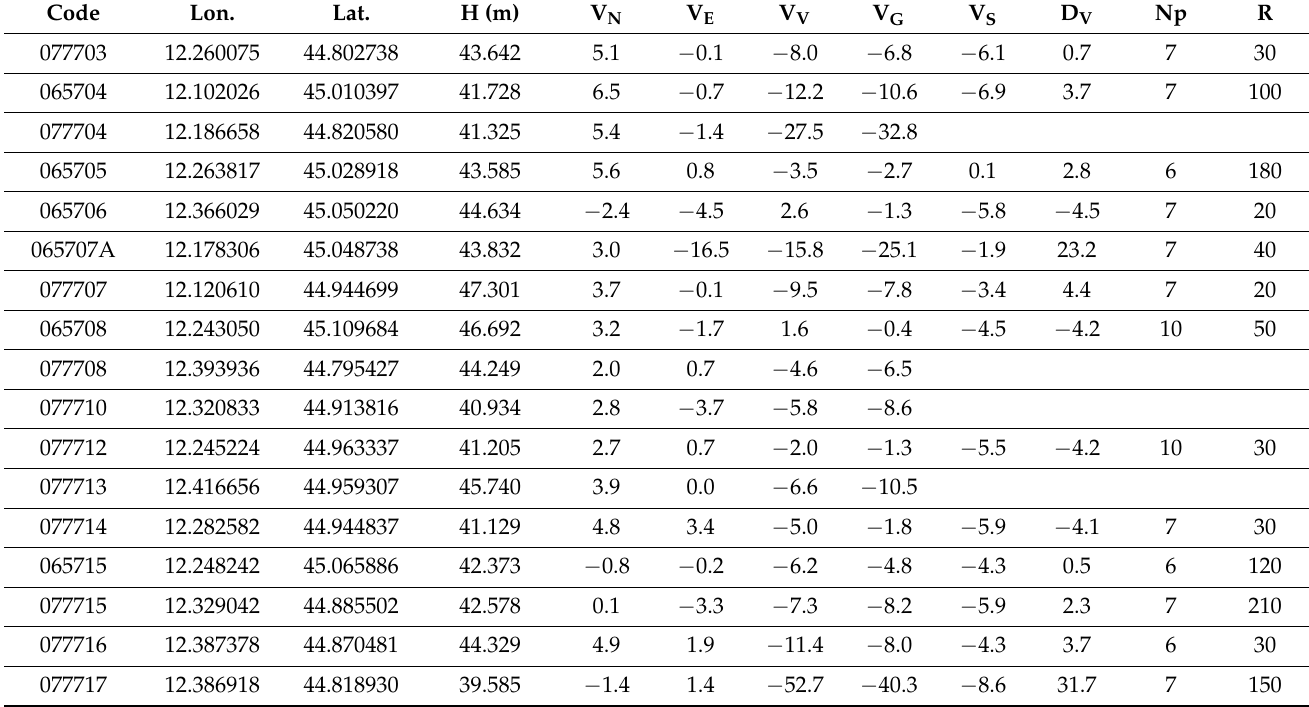
Table 3. Velocities of the PODELNET sites were estimated by comparing the positions obtained analyzing the two surveys (2016–2018). The code of the PODELNET sites, defined by the IGMI, is reported in the first column; in the subsequent three columns are shown the geographical coordinates: Longitude and Latitude in centesimal degrees and the Height (H) in the WGS84 ellipsoid, in meters. The velocity components in mm/year along the North (V N ), East (V E ), and Vertical (V V ) directions are also reported. The velocities along the LOS direction of Sentinel-1A/B satellites are shown in the V G column, in mm/year. The InSAR velocities, in mm/year, in the PODELNET sites are reported in V S column; D V are the differences, in mm/year, between the InSAR (V S ) and GNSS (V G ) velocities (D V = V S − V G ). Np is the number of InSAR points used to obtain the V S rate, and R is the minimum radius, in meters, adopted to find the number of points. The values of PTO1 and TGPO permanent sites were obtained using only the observations acquired during the two PODELNET surveys and processed with the data of these campaigns.